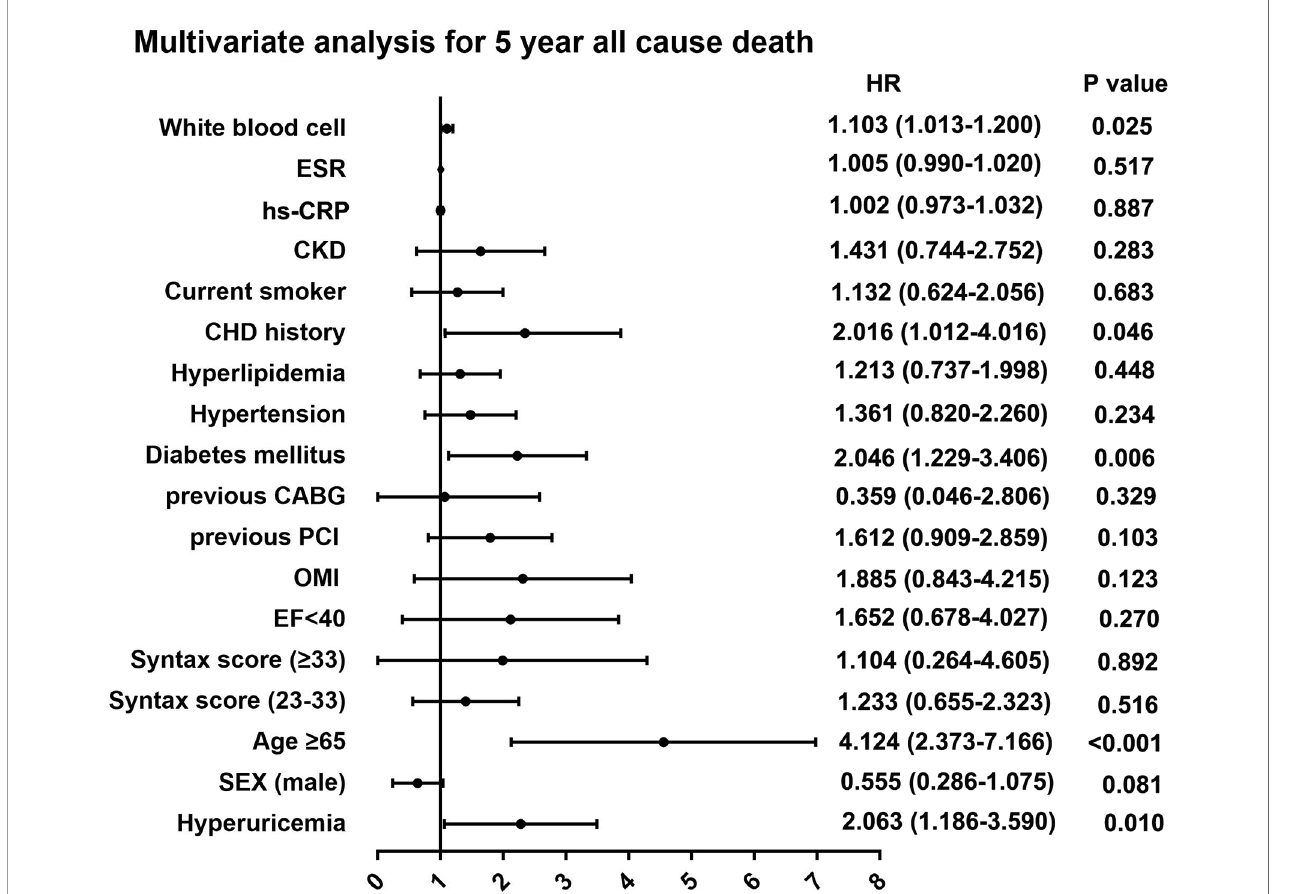
FIGURE 4 | Multivariate analysis for 5-year primary outcome in patients with STEMI. ESR, erythrocyte sedimentation rate; hs-CRP, high sensitive C-reactive protein; CKD, chronic kidney disease; CHD, coronary heart disease; CABG, coronary artery bypass grafting; PCI, percutaneous coronary intervention; OMI, old myocardial infarction; EF, ejection